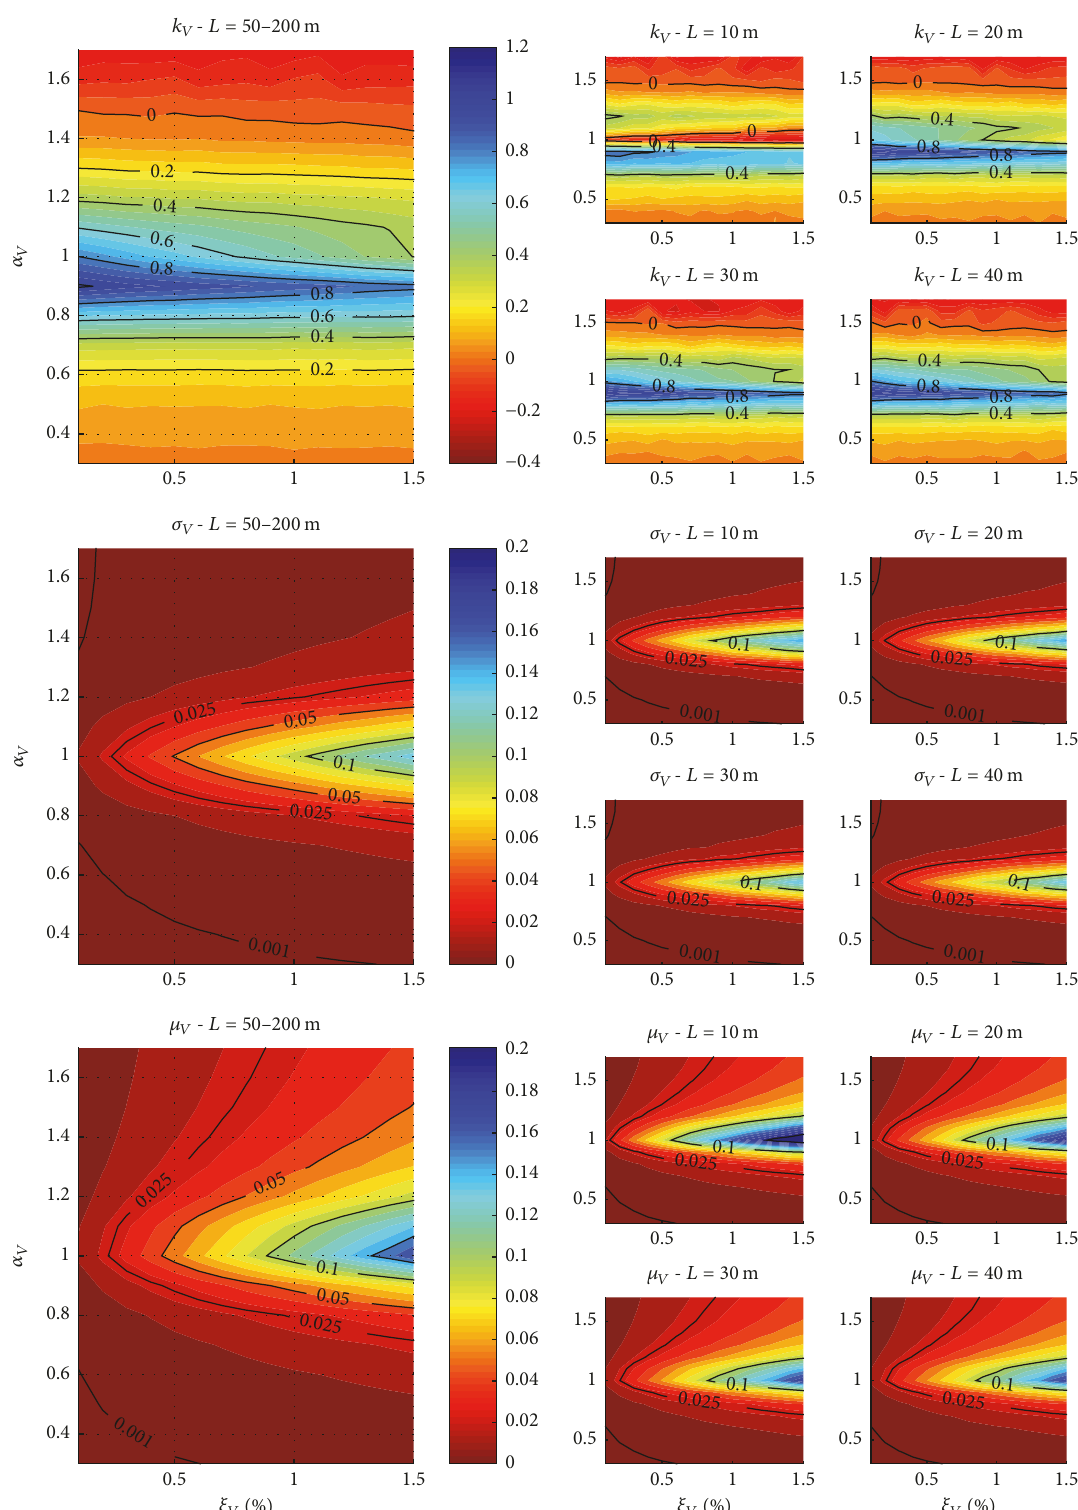
(𝜑 ( RL = 0, 𝛼 ,𝐿,𝜉 )) : simply supported case in vertical 𝑉 𝑉 𝑉 𝑉 𝑉